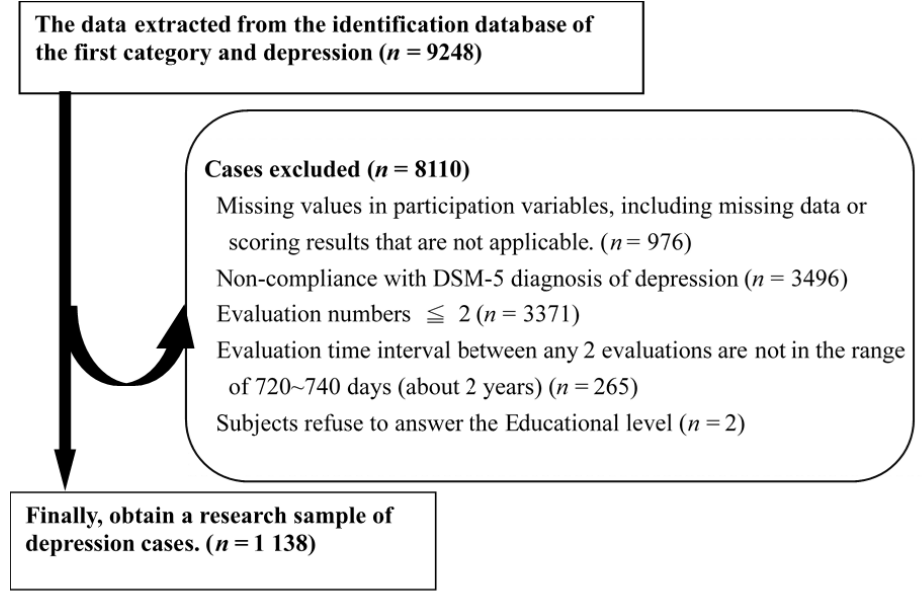
Figure 1. The selection and exclusion process of participants.